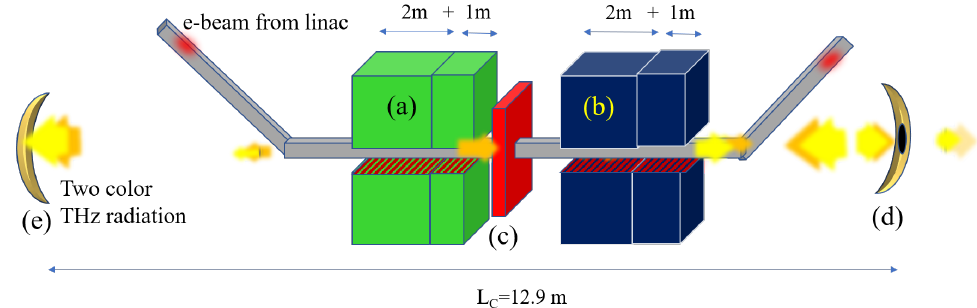
Figure 2. Scheme of the two-color radiation source. ( a , b ) Undulator modules (2 + 1 m long), ( c ) quadrupole for electron-beam matching, ( d ) front mirror, ( e ) rear mirror. Cavity length L c = 12.9 m. Metal-coated mirrors: curvature radius about 15–25 m, reflectivity about